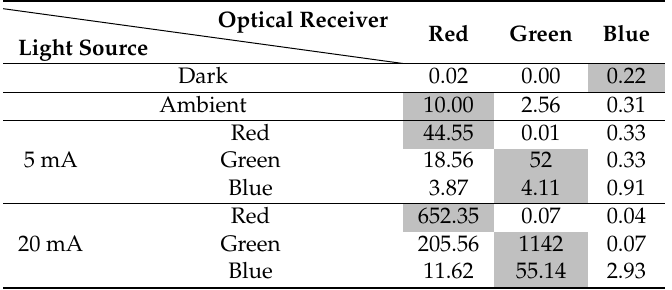
Table 2. Photo-current values expressed in nA, generated by different LEDs used as optical sensors. The highest photo-current values are